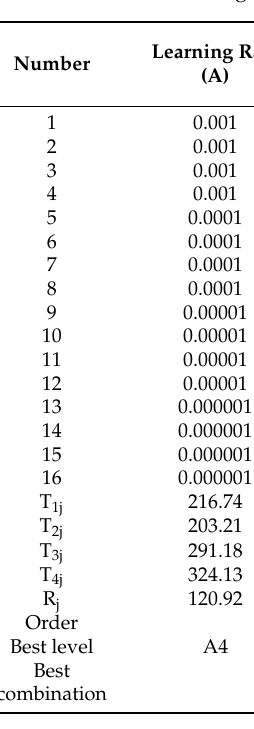
Table 3. The second orthogonal